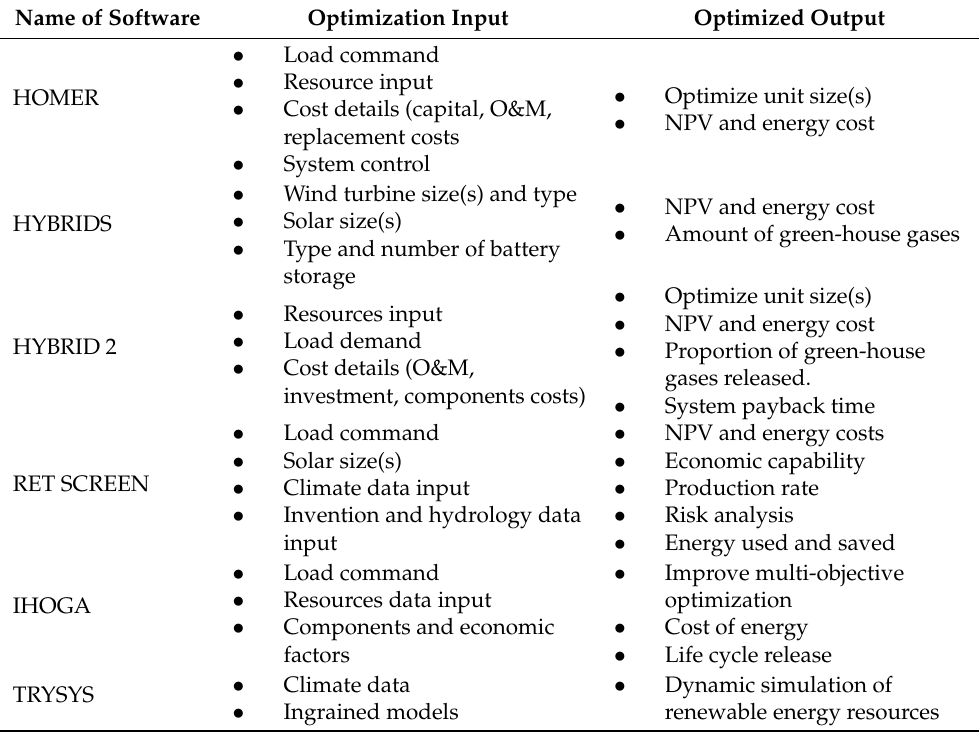
Table 3. Software applications for optimizing